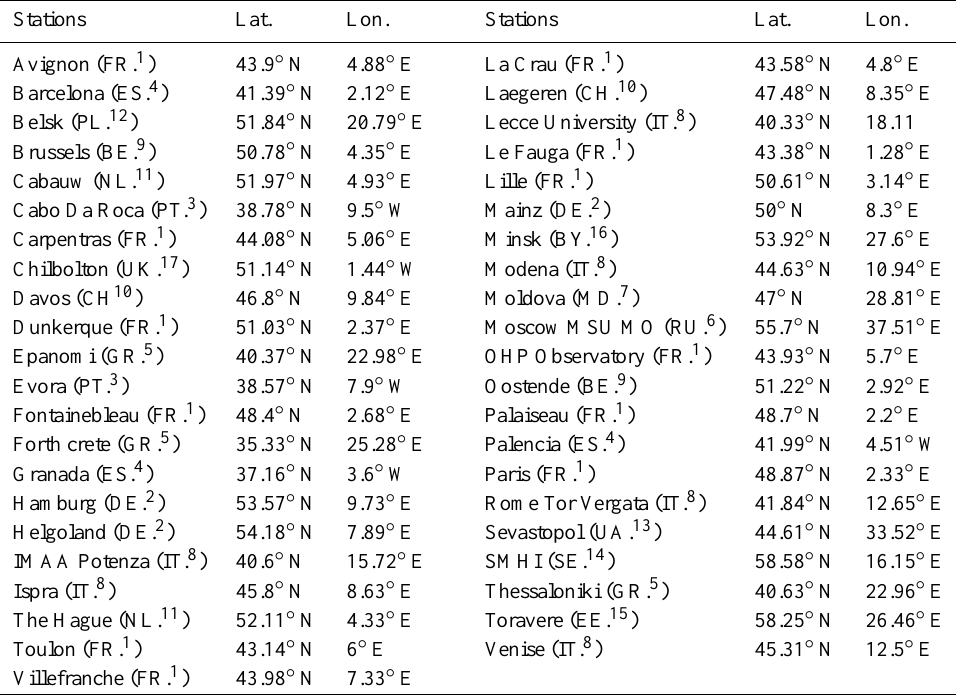
Table 2. Coordinates and description of the 43 AERONET stations used for the validation. Stations Lat.